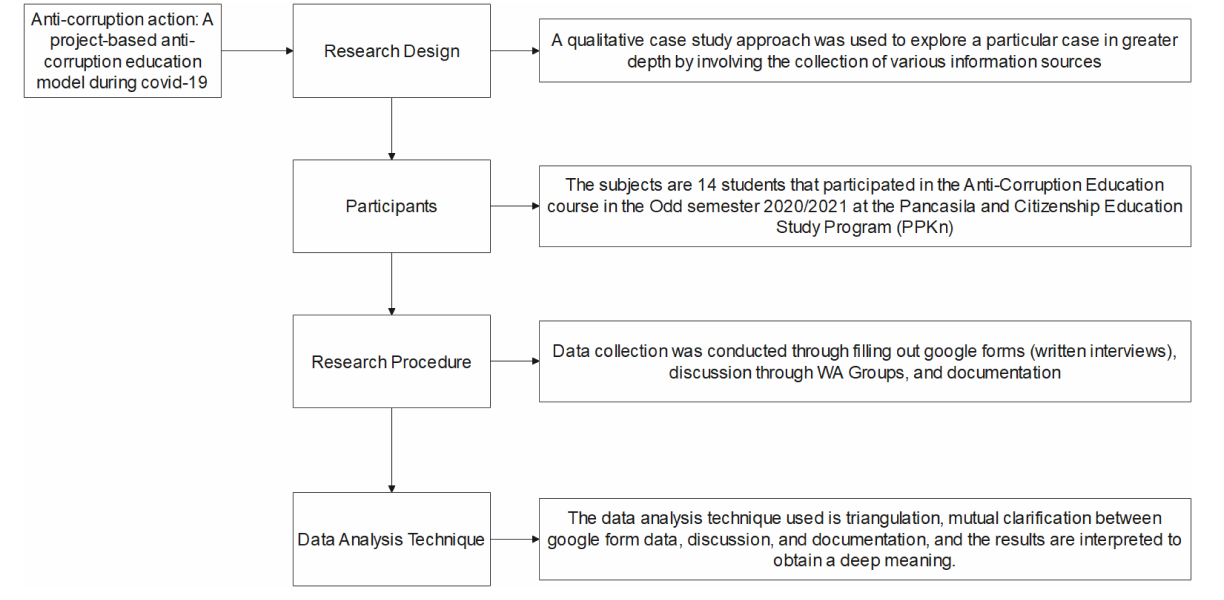
Discussion sub-title are presented separately. This section should occupy the most part, minimum of 60%, of the whole body of the article. Figure 2 explain anti-corruption action: a project-based anti-corruption education